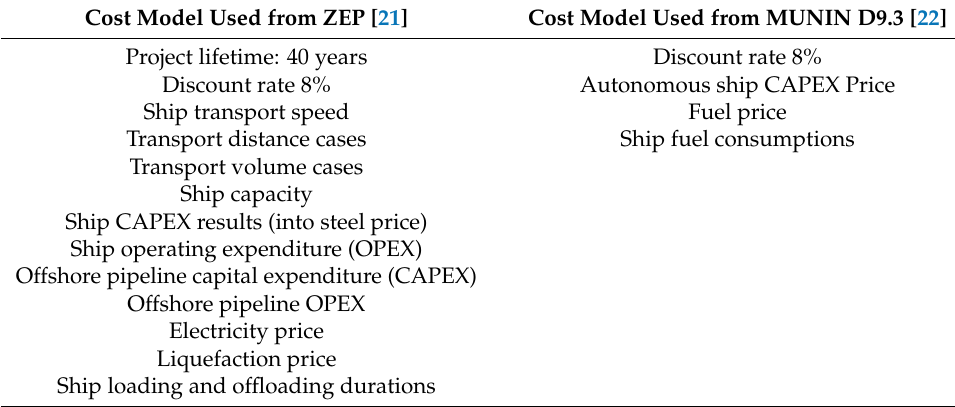
Table 9. Cost models used from ZEP and MUNIN D9.3